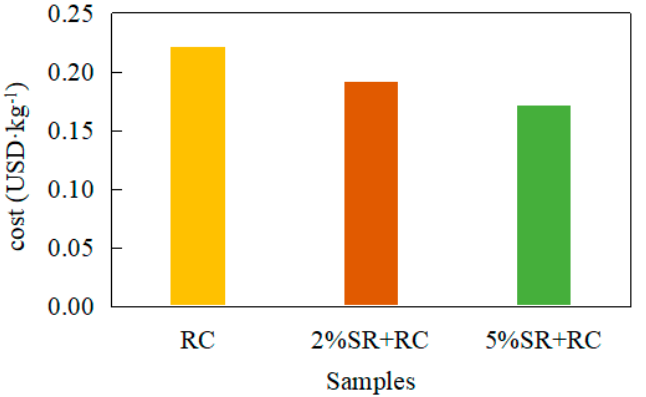
Figure 14. Effects of soda residue on the economic benefits of coking coal drying.